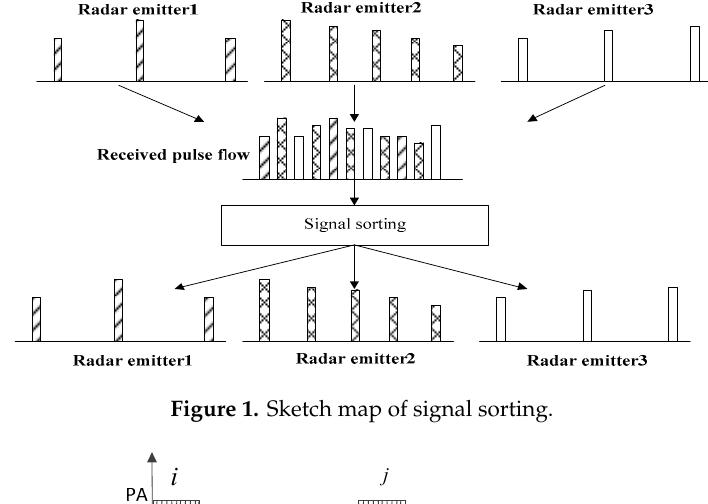
Figure 1. Sketch map of signal sorting.